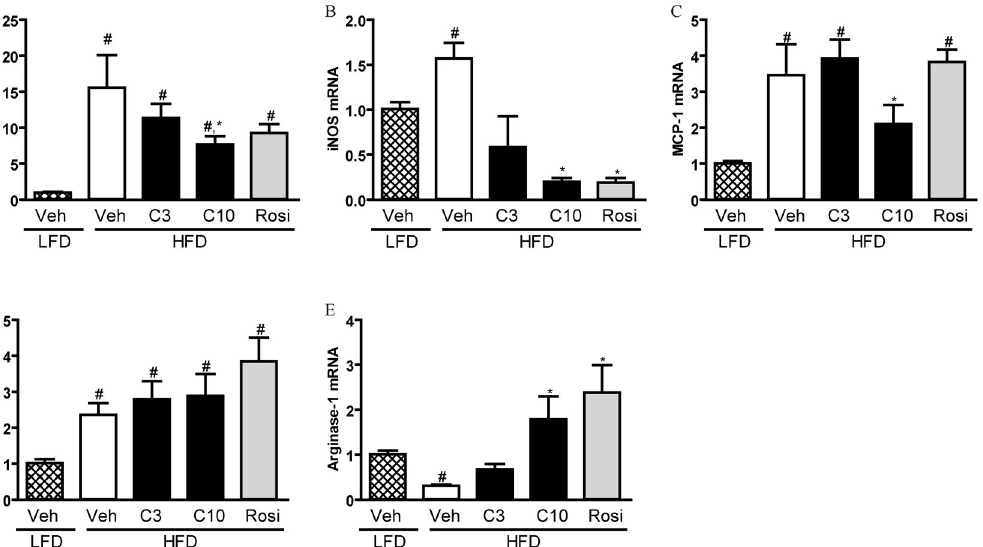
Figure 7. Anti-inflammatory effect of CMHX008 is dependent on the change in adipose tissue macrophage polarization. C57BL/6 mice were fed with HFD or LFD for 16 weeks. Then HFD fed C57BL/6 mice were treated with CMHX008 (3 and 10 mg/kg, HFD-C3 and HFD-C10), rosiglitazone (3 mg/kg, HFD-Rosi) or vehicle (HFD-Veh or LFD-Veh) only, for additional 5 weeks. Epididymal adipose tissues were harvested for total RNA extraction and the mRNA expression of CD11c (A), iNOS (B), MCP-1 (C), CD206 (D) and arginase-1 (E) was analyzed by real-time PCR. Data are the means 6 S.E.M., n=6–8; # P , 0.05 vs LFD-Veh and * P , 0.05 vs HFD-Veh.